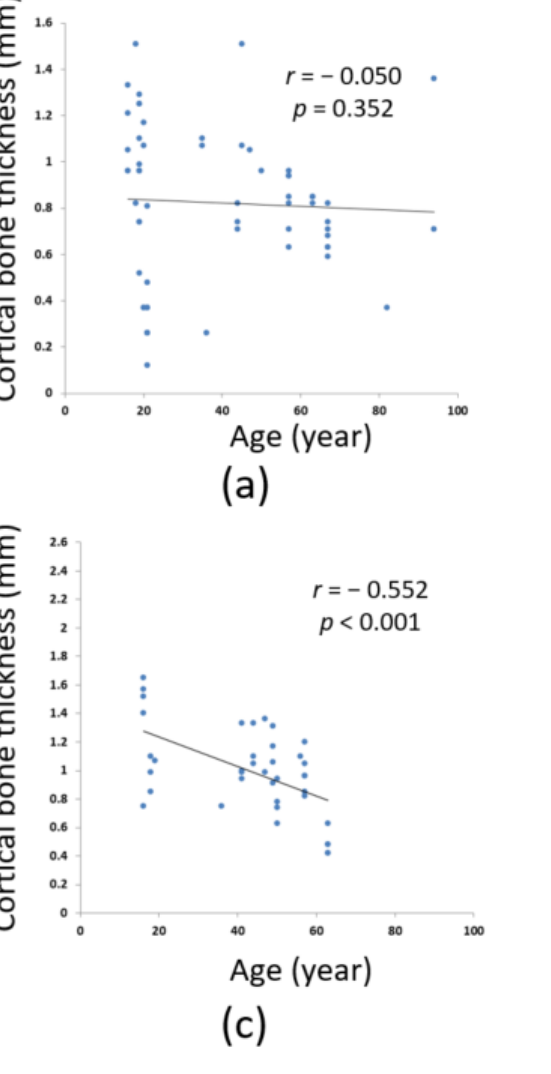
Figure 4. Relationships between cortical bone thickness at dental implant sites and age in the: ( a ) anterior maxilla; ( b ) posterior maxilla; ( c ) anterior mandible; ( d ) posterior mandible.